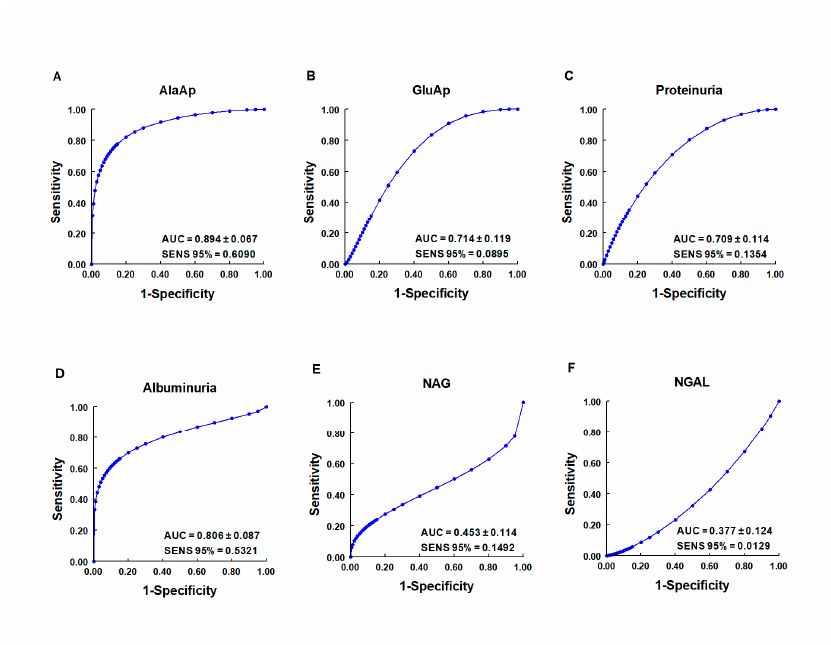
Figure 5. ROC curves showing specificity and sensitivity for APN (AlaAp) ( A ), APA (GluAp) ( B ), proteinuria ( C ), albuminuria ( D ), N-acetyl- β -D-glucosaminidase (NAG) ( E ), and neutrophil gelatinase-associated lipocalin (NGAL) ( F ) to differentiate cisplatin-treated rats from control rats 24 h after injection of saline, 3.5 or 7 mg/kg of cisplatin ( n = 8 each group). All cisplatin-treated rats displayed tubular dysplasia and interstitial fibrosis 14 days after injection. Urinary markers were expressed in daily total activity or excretion per 100 g of body weight. AUC = area under the curve. SENS 95 % = calculated sensitivity at 95 % of specificity.